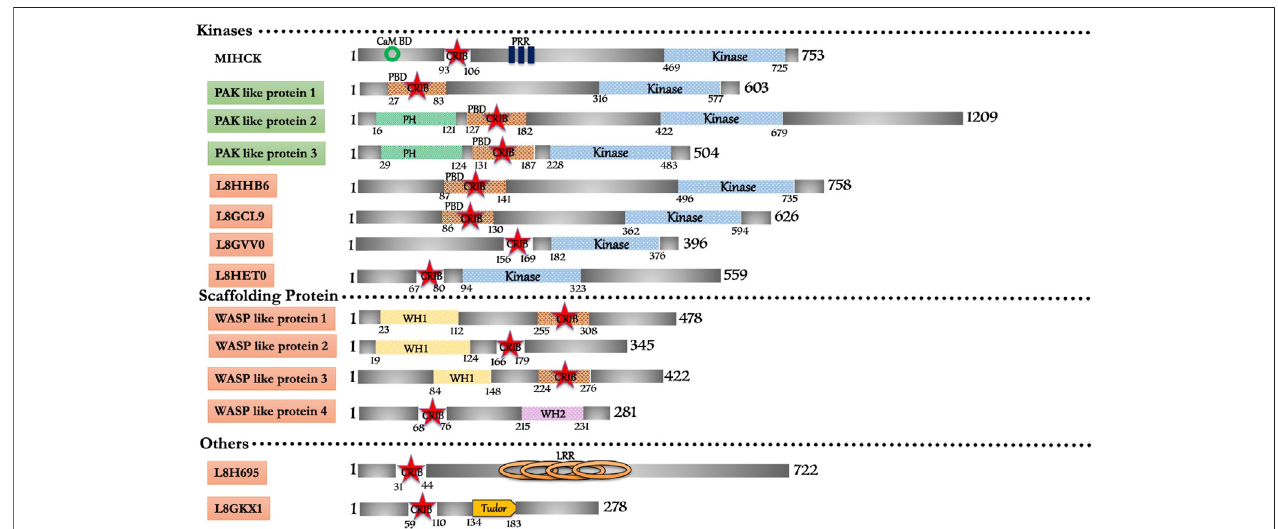
FIGURE 3 | Schematic diagram of domain organization of Acanthamoeba castellani CRIB domain containing proteins. The abbreviations for the domains are: CRIB, Cdc42/Rac interactive binding; CaM BD, Calmodulin Binding Domain; LRR, Leucine Rich Repeat; PBD, p21-activated binding domain PH, pleckstrin-homology; PRR, Proline Rich Region; WH1, Enabled/VASP homology 1; WH2, WASP homology 2. The proteins already known from the earlier literature, but not characterized yet are marked as green colored box. The proteins marked in orange (subtle effect) boxes are reported for the fi rst time in this in silico study and are completely uncharacterized.Footnote:InAcanthamoebacastellani,thebiochemicalcharacterizationisonlyavailableforMIHCK,reported2decadesago.However,inourstudy,we report the highest number of CRIB domain-containing proteins from this organism. Their identi fi cation opens all kinds of structural, biochemical, biophysical and cellular study avenues for further research. The detailed study on the proteins with entirely novel domain combinations is highly relevant for further research as drug candidates.